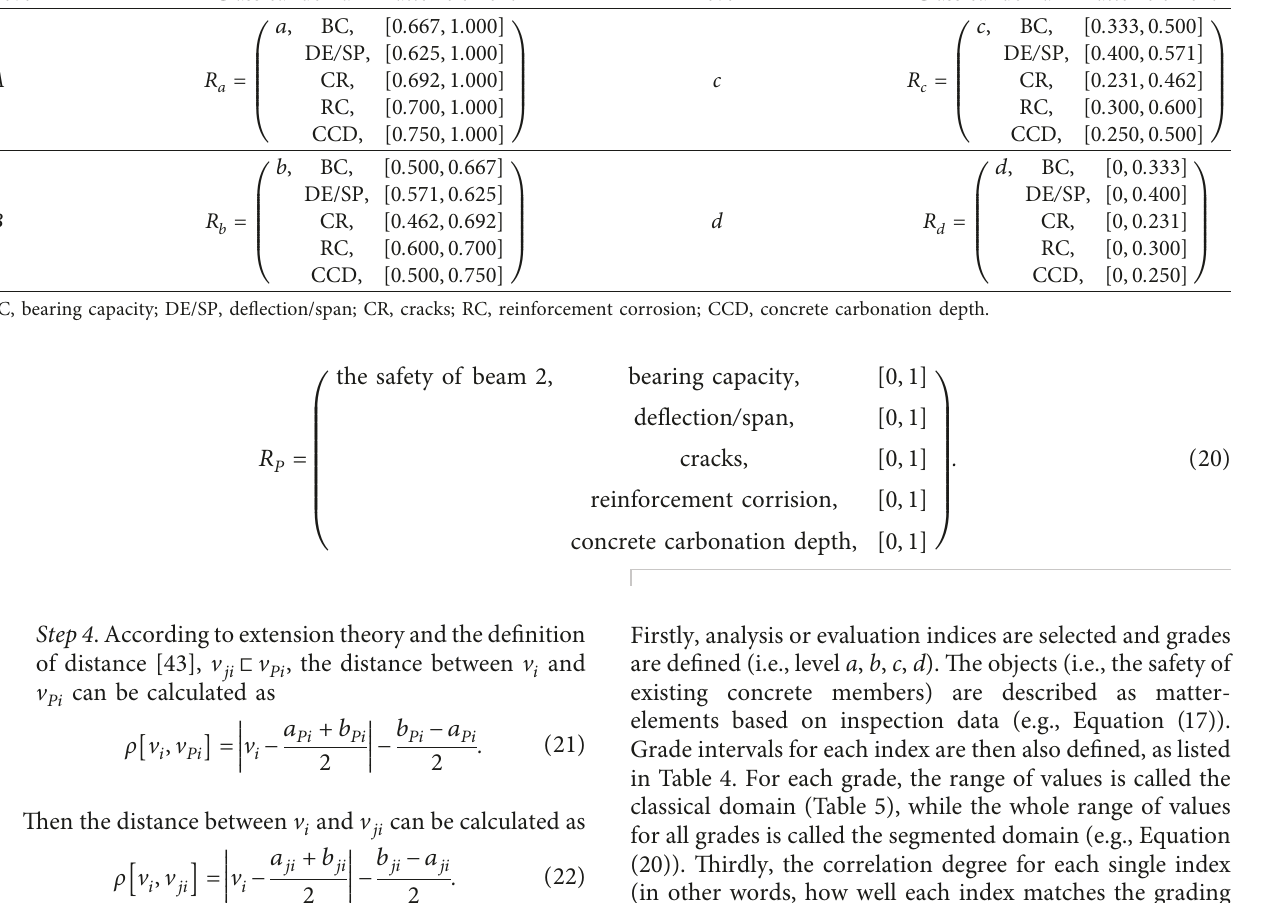
Table 5: The classical domain matter-element (normalized) for each safety level.